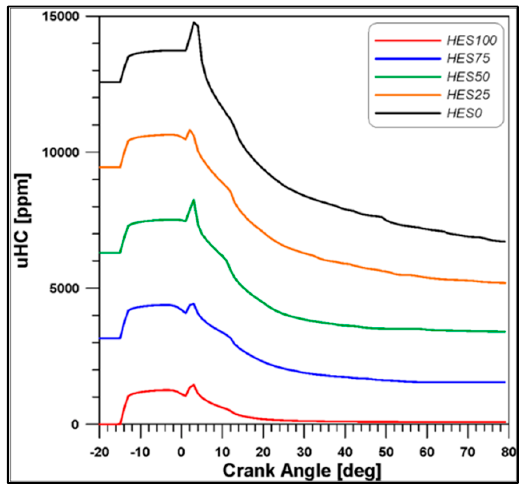
Figure 28. HC pollutant.